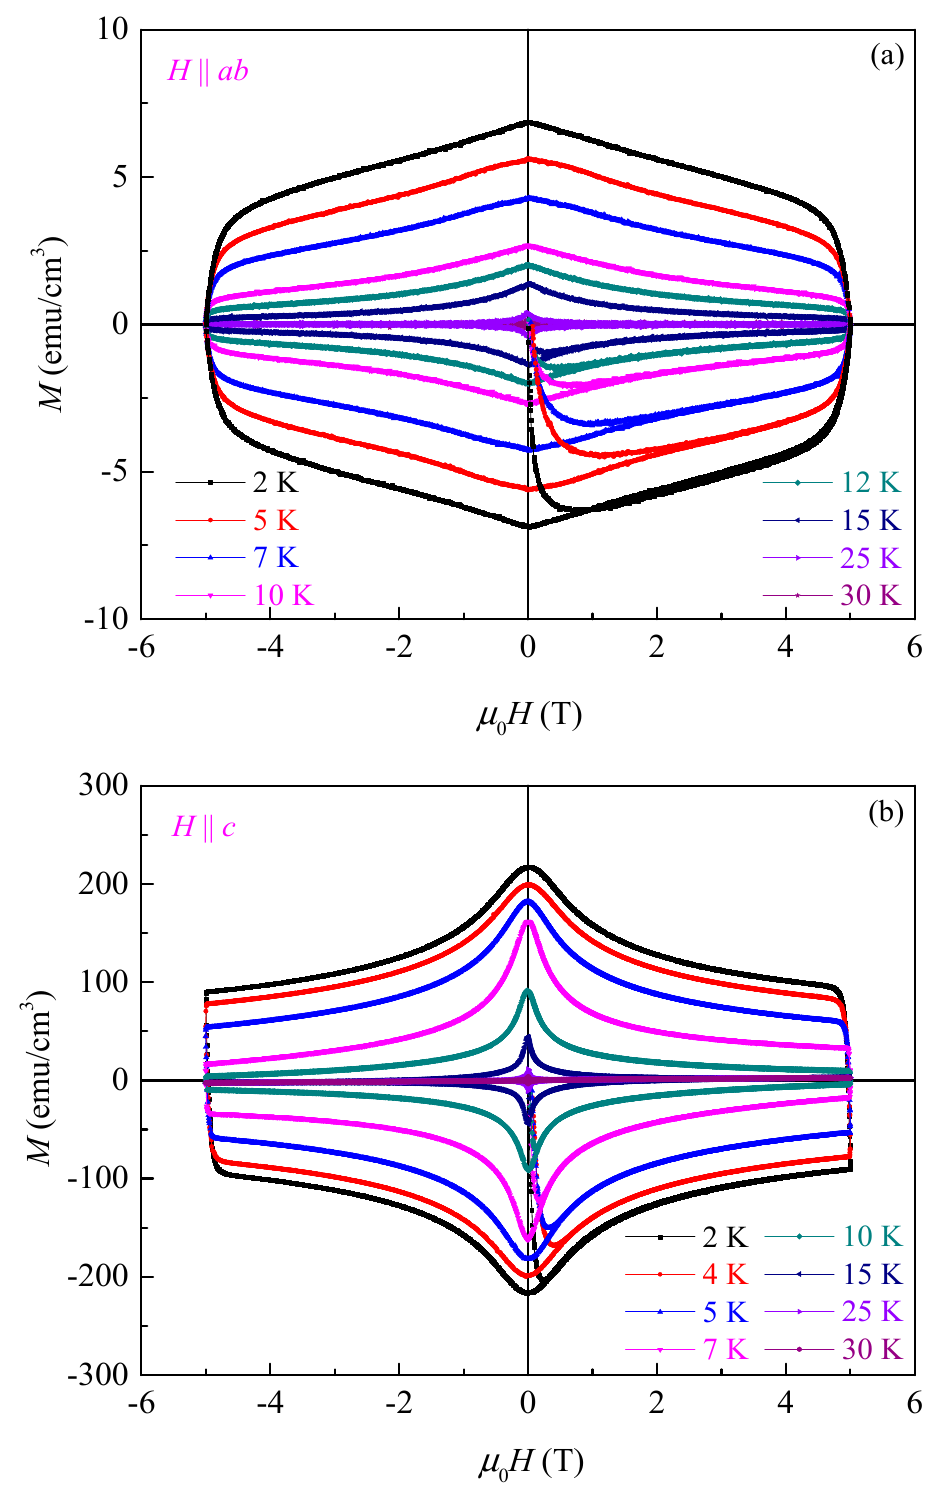
Figure 16. Magnetization hysteresis loops for ( a ) H || ab and ( b ) H || c .